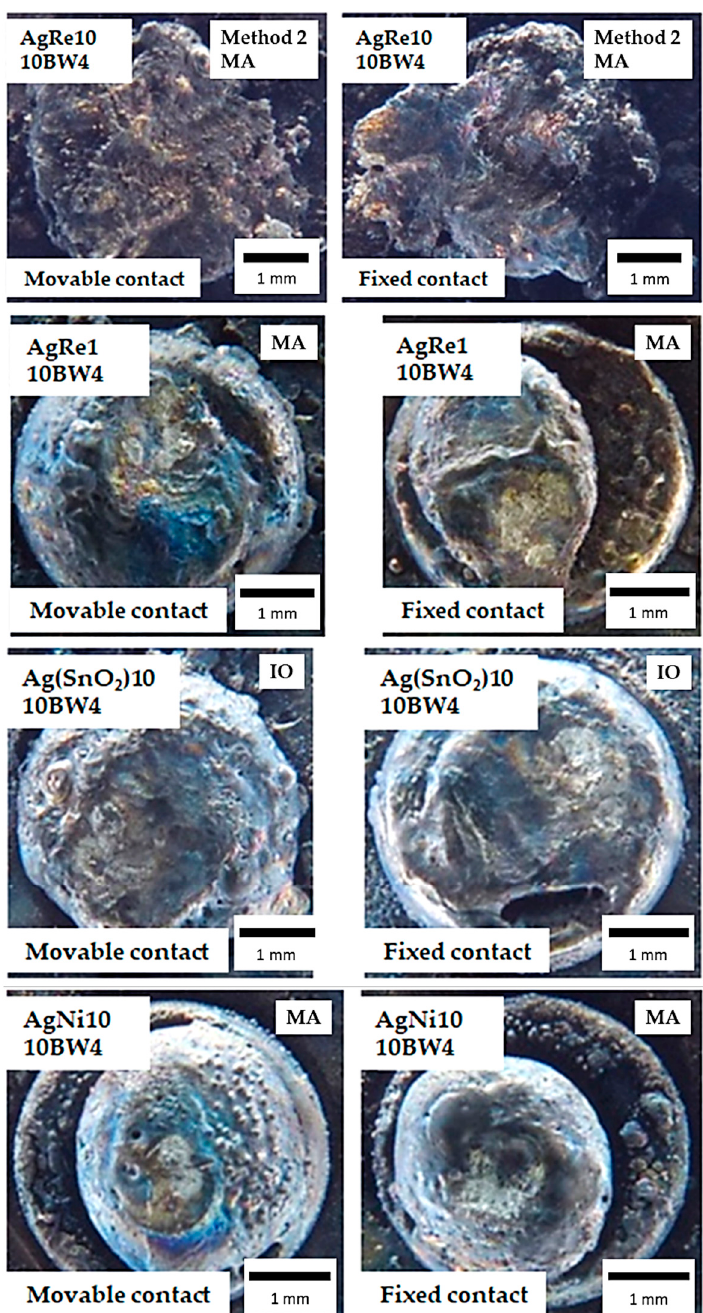
Figure 8. Macro photographs of contact surface after the arc erosion testing AC current = 60 A, voltage = 230 V, MA = Mechanical Alloying, IO = Internal Oxidation.